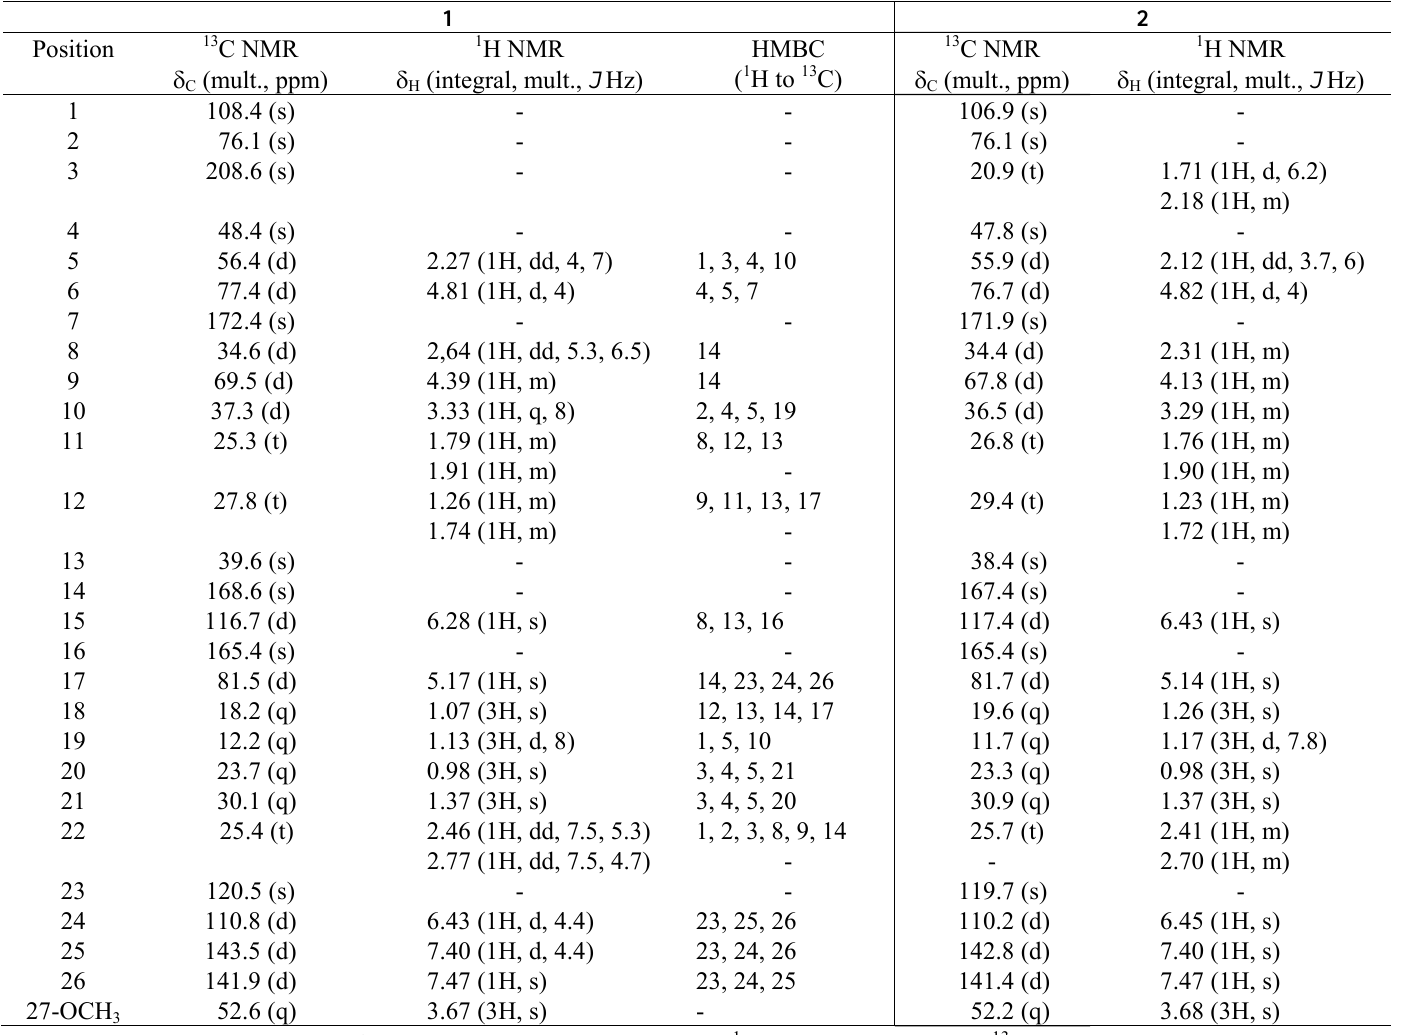
Table 1. NMR spectral data for compounds 1 and 2 .